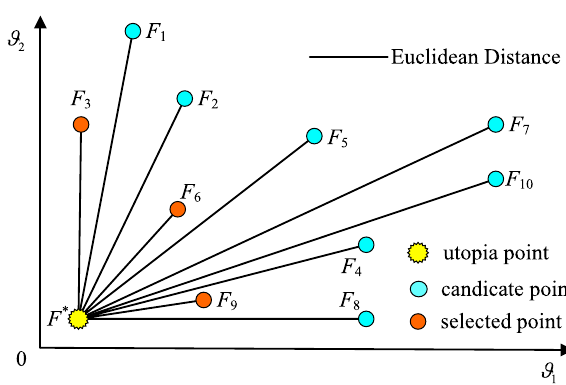
Fig. 1 Illustration of the proposed decomposed MOO